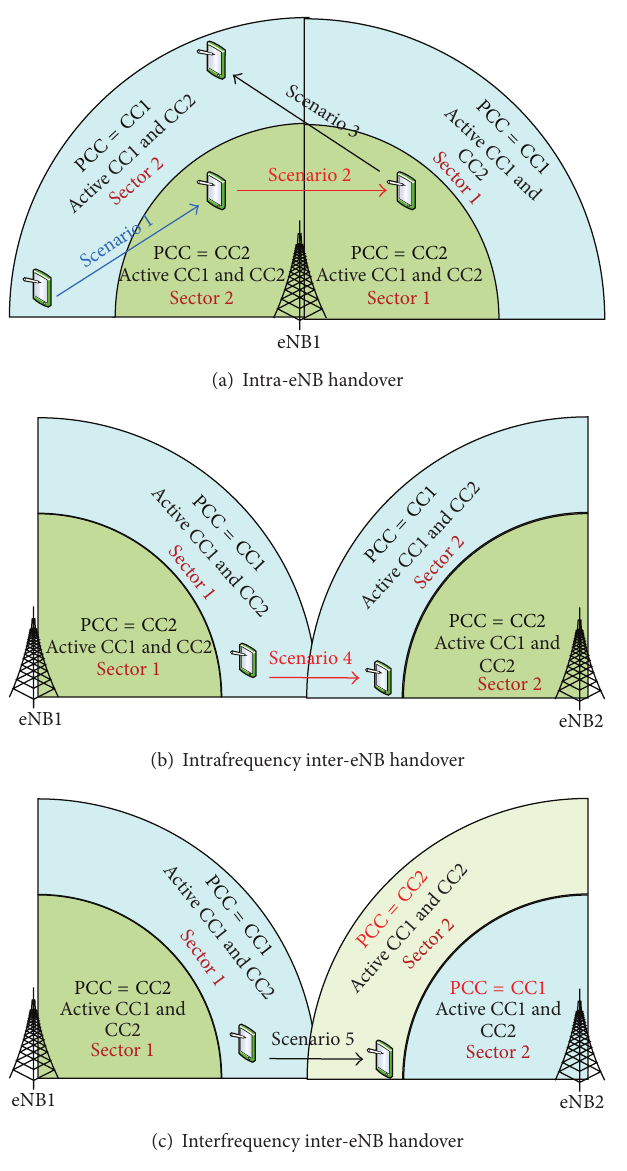
Figure 2: Frequency handover